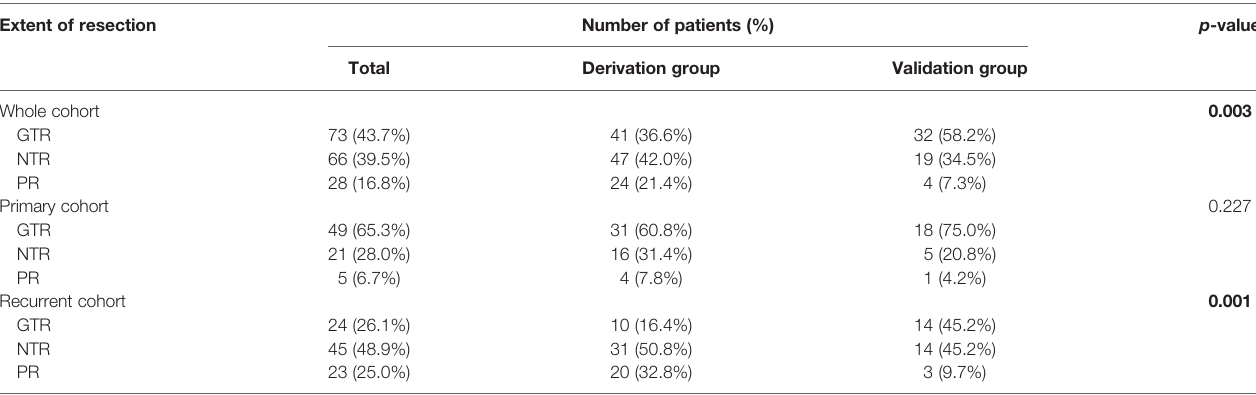
TABLE 3 | Extent of resection in the derivation group and the validation group.